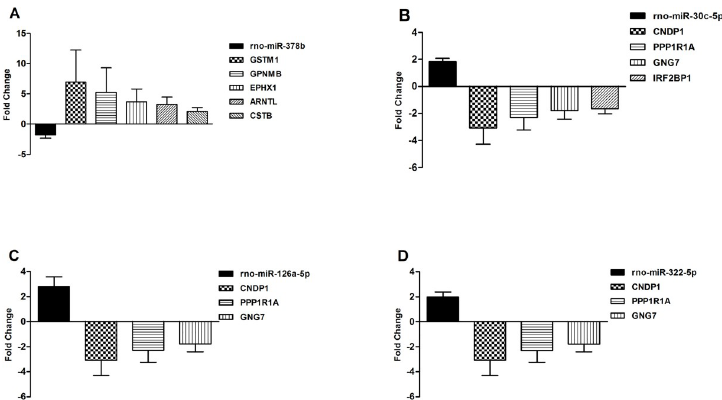
Fig 7. Putative negative miRNA-mRNA pairs validated by RT-qPCR ( P < 0.05).